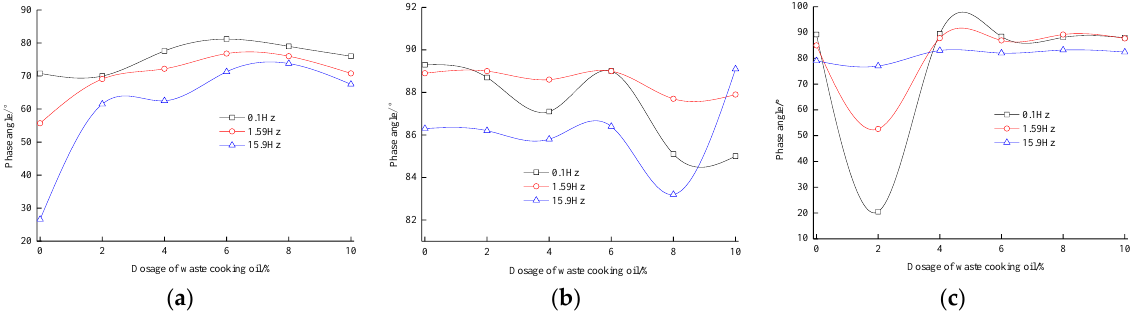
Figure 1. The interrelation between the phase angle and dosage of modified asphalt with waste cooking oil [19]. ( a ) Rock asphalt. ( b ) Petroleum asphalt. ( c ) Rock asphalt/Petroleum asphalt.